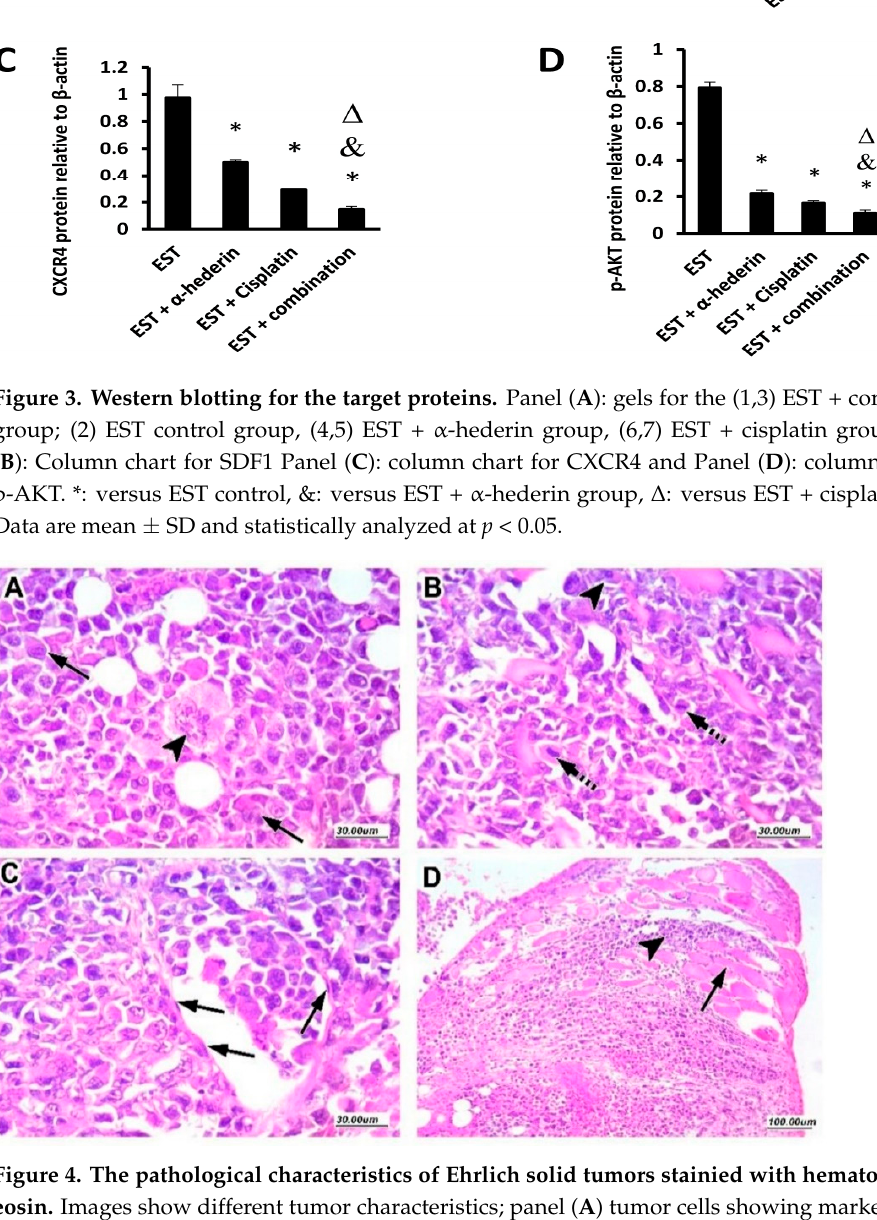
Figure 4. The pathological characteristics of Ehrlich solid tumors stainied with hematoxylin and eosin. Images show different tumor characteristics; panel ( A ) tumor cells showing marked nuclear and cellular pleomorphism and hyperchromasia with enlarged nuclei and prominent nucleoli (arrow), with scattered multinucleated tumor giant cells (arrowhead). Panel ( B ) shows multiple mitotic figures (dashed arrow), indicating high mitotic activity with abnormal mitotic figures (arrowhead), a feature of malignant tumor. Panel ( C ) shows lymphovascular invasion by tumor cells; the vessel contour is indicated by arrows pointing out endothelial cell lining of vessel wall. Panel ( D ) is a low-magnification image of tumor cells (arrowhead) infiltrating the surrounding skeletal muscle fibers